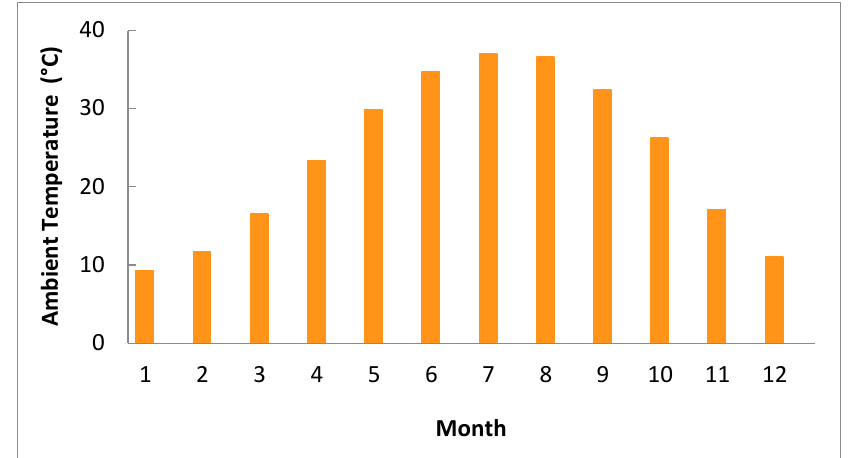
Figure 4. Monthly average ambient temperature.